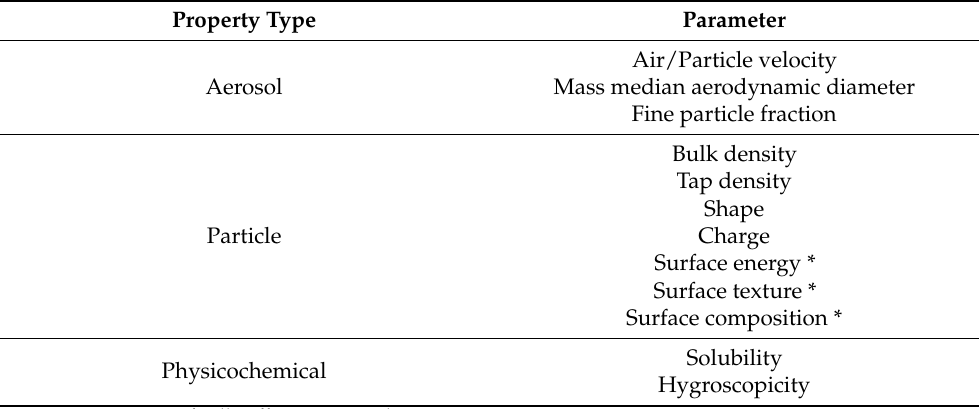
Table 1. Physicochemical factors to be considered when designing inhaled formulations. Each parameter influences both aerosolisation and deposition. Adapted from the work by the authors of